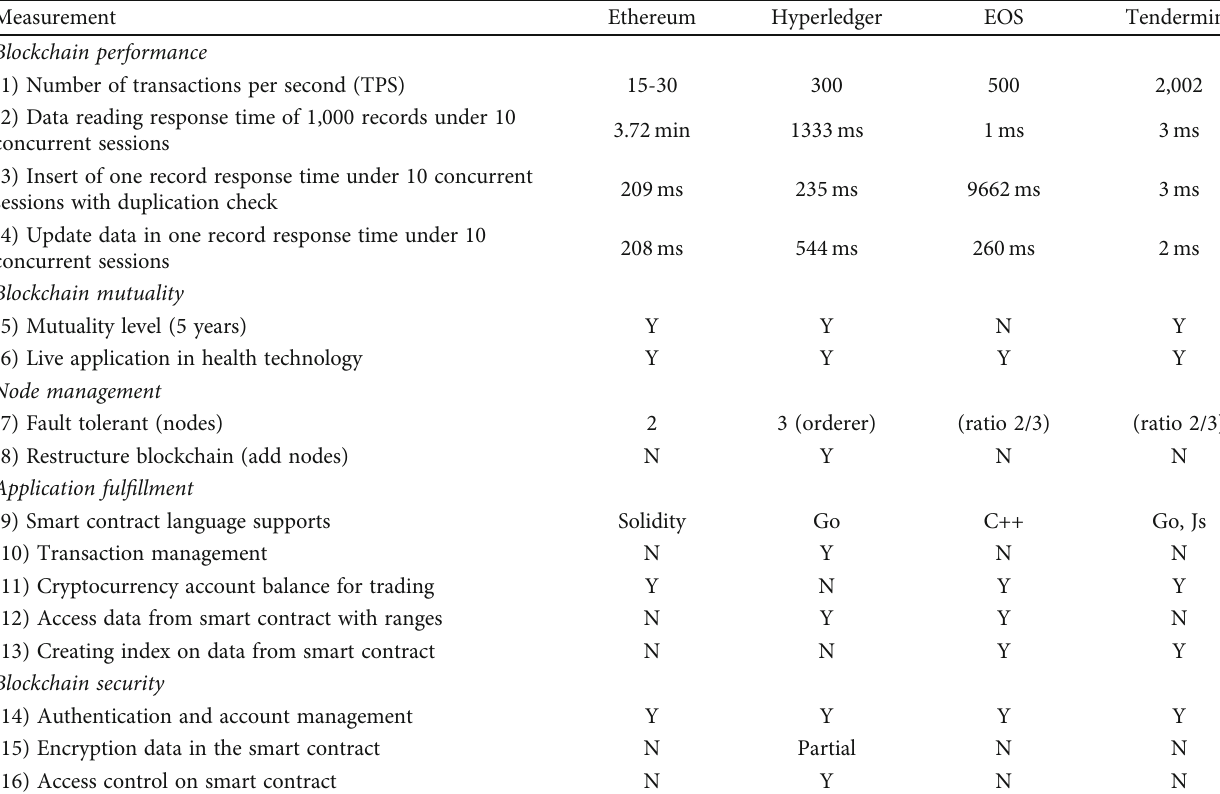
Table 1: Blockchain technology comparisons for telehealth